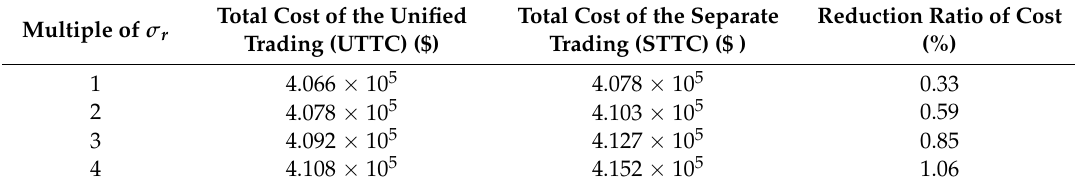
Table 4. The impact of σ r on the total costs.